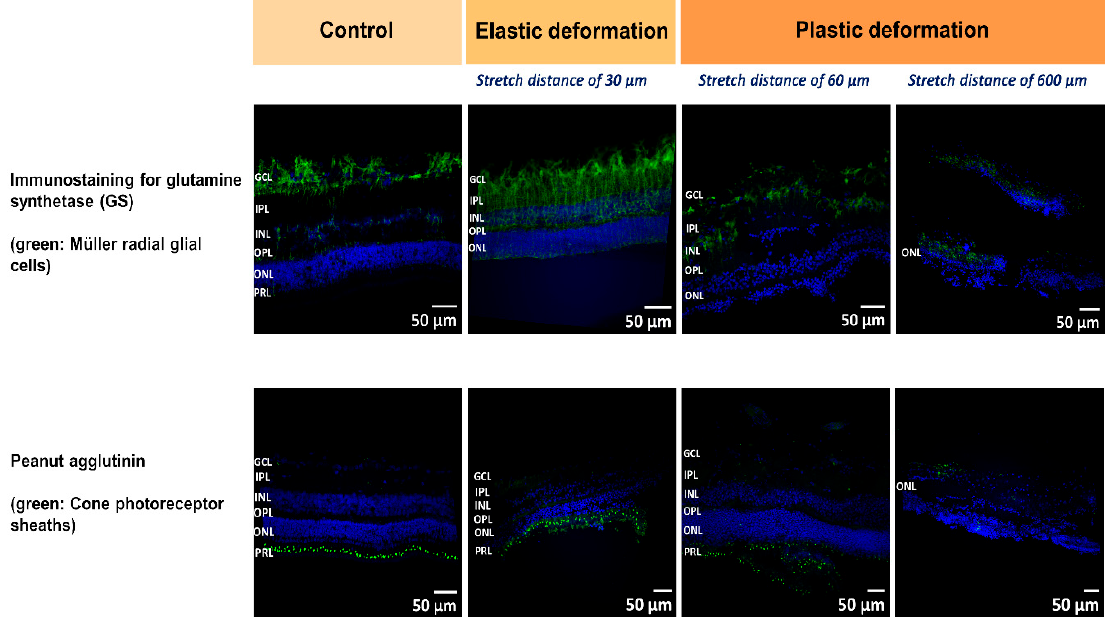
Figure 5. Labeling of porcine retinae to visualize cell processes (immunohistochemistry) and nuclei (blue staining by Hoechst 33342) indicating the retinal layers; GCL, ganglion cell layer; IPL, inner plexiform layer; INL, inner nuclear layer; OPL, outer plexiform layer; ONL, outer nuclear layer; and PRL, photoreceptor layer. Retinal tissue was labeled after a 0.1 µ m / s deformation over a stretch distance of 30 µ m (elastic deformation) and 60 µ m or 600 µ m (plastic deformation), respectively; left column: controls. Müller (radial glial cell) processes were labeled by immunostaining for glutamine synthetase (green, top row). The sheaths of cone photoreceptor cells were labeled by peanut agglutinin (green, bottom row).